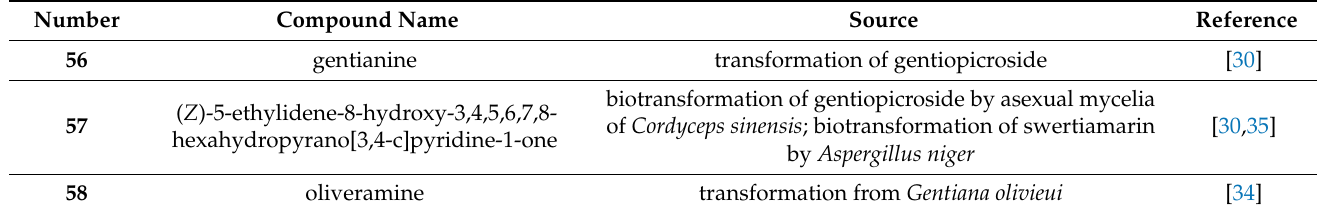
Figure 6. Structures of pyridines alkaloids derived from lactone secoiridoids (Type V). Table 5. Pyridines alkaloids derived from lactone secoiridoids (Type V).